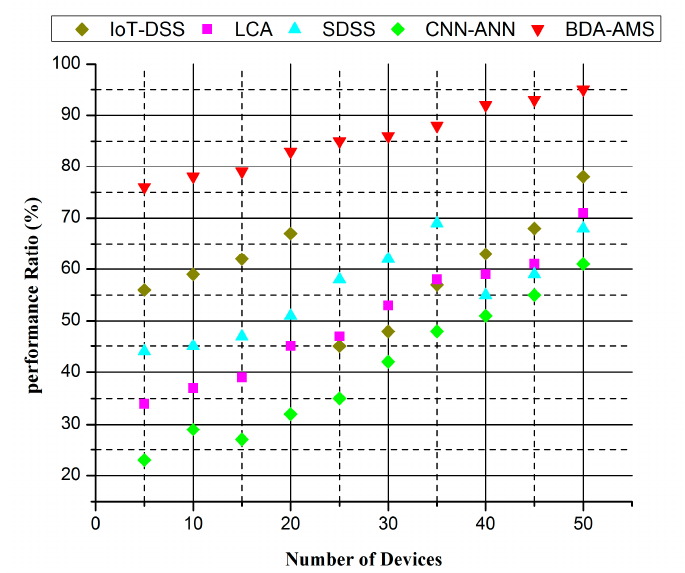
Figure 12. Performance ratio (%).